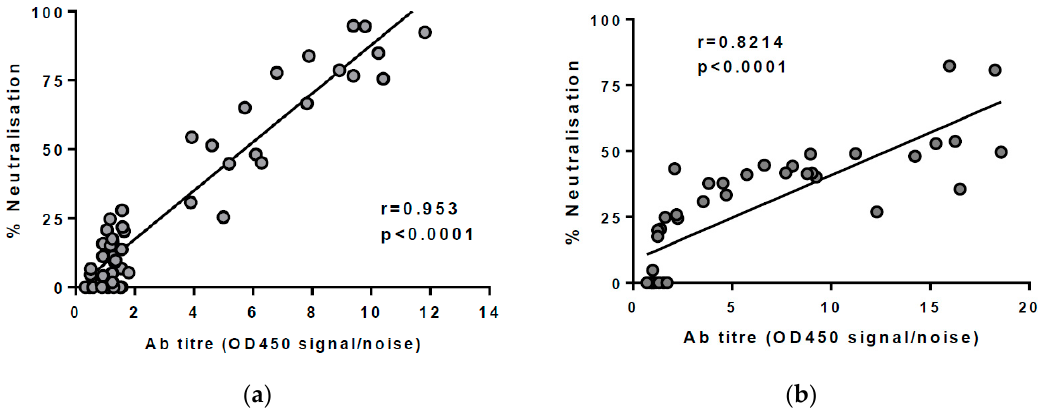
Figure 1. Linear regression analysis of anti-E1/E2 IgG titres (optical density 450 signal/noise) and percentage neutralisation (%) of HCVpp carrying the same envelope sequence. A significant correlation was found in ( a ) matched Gt1 envelope sequences (H77.20, r = 0.953, p < 0.0001) and ( b ) matched Gt3 envelope sequences (UKN3A.13.6, r = 0.8214, p < 0.0001) demonstrating that neutralisation of HCVpp was likely be associated with anti-envelope IgG in the plasma.